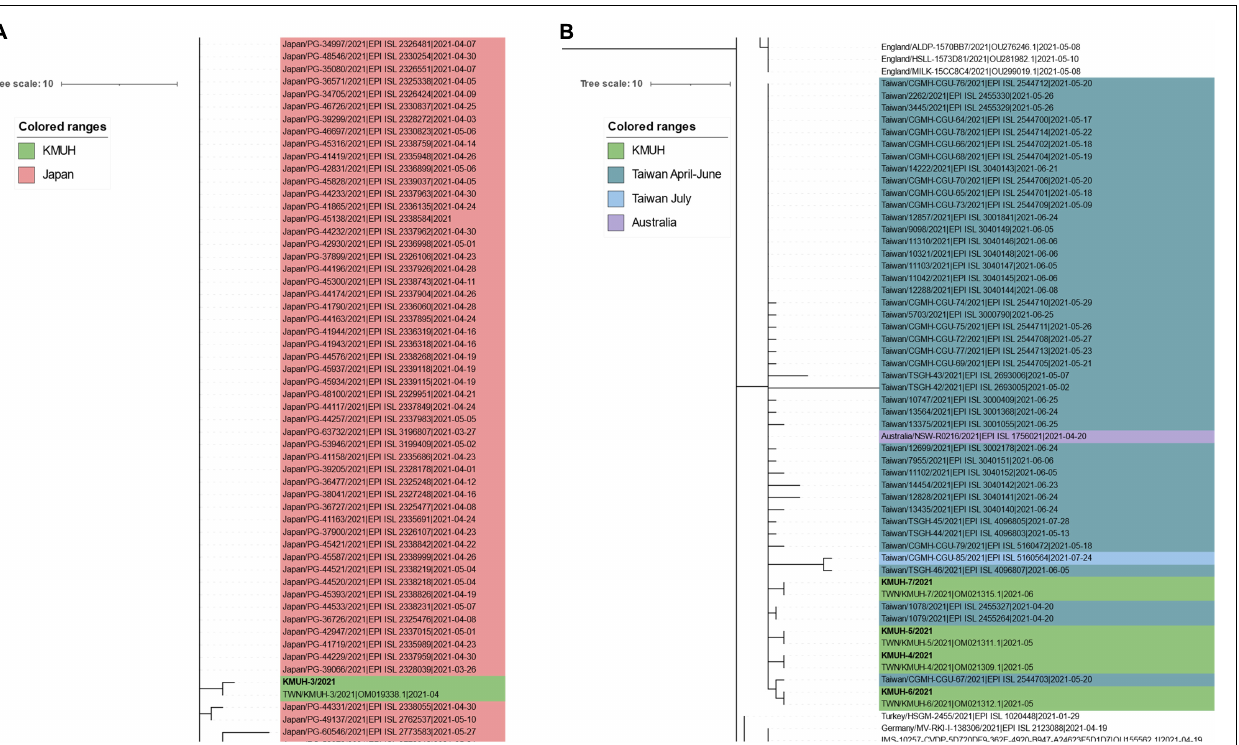
FIGURE 3 | Phylogenetic analysis of KMUH-3 to KMUH-7 SARS-CoV-2 using UShER. UShER enables real-time sequence placement for the SARS-CoV-2 pandemic using an existing phylogenetic tree generated by the sarscov2phylo pipeline, which contains 6,624,590 genomes from GISAID, GenBank, COG-UK, and CNCB (2 January 2022). The phylogenetic subtree data are visualized using Interactive Tree Of Life (iTOL) version 6.4.3 (https://itol.embl.de/) (73). The 200 nearest neighboring GISAID EpiCoV and/or other publicly available SARS-CoV-2 sequences, including the sequences uploaded for analysis, already in the existing phylogenetic tree were output for visualization. Only partial results are shown in each subtree panel. (A) The 200 nearest neighboring sequences to the KMUH-3 are all retrieved from Japan. (B) The 200 nearest neighboring sequences to KMUH-4 to KMUH-7 were retrieved from Taiwan, Australia, and European